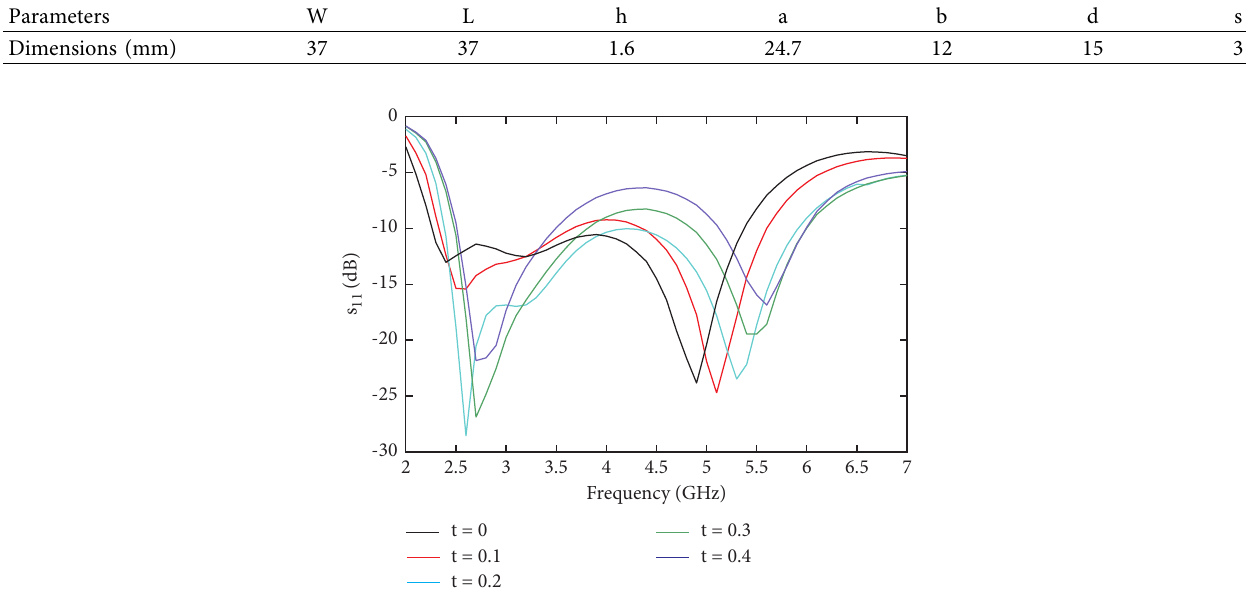
Figure 7: S results with different t values. 11